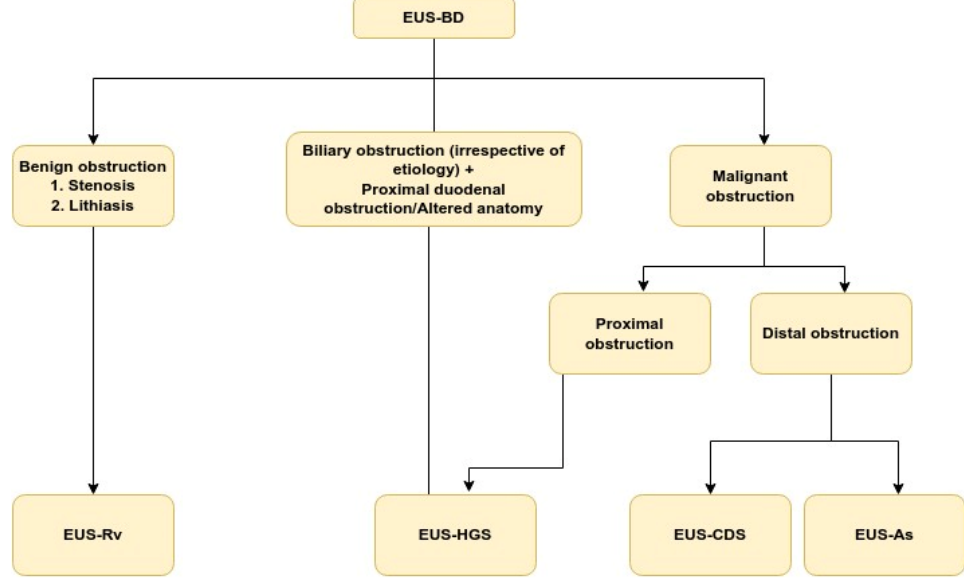
Figure 2. Summary of current indications for EUS-BD. EUS-BD: Endoscopic ultrasound-guided biliary drainage; EUS-RV: EUS-guided rendezvous technique; EUS-As: EUS-guided antegrade stenting; EUS-CDS: EUS-guided choledochoduodenostomy; EUS-HGS: EUS-guided hepaticogastrostomy.